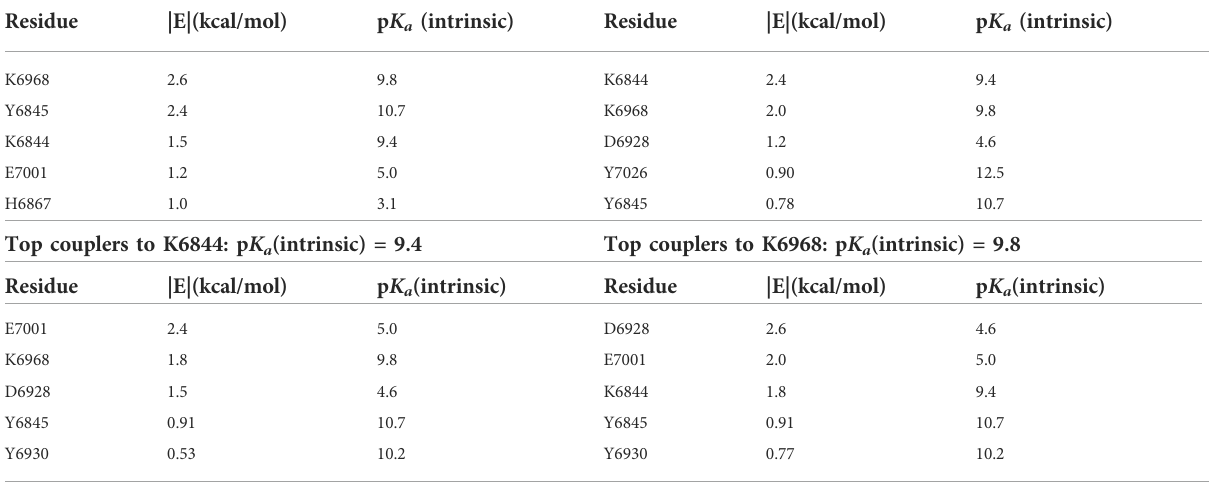
TABLE 4 Computed pairwise energies of electrostatic interaction (kcal/mol) between three of the members of the catalytic tetrad D-K-E, D6928, K6968, and K7001, plus the coupled K6844, and their fi ve strongest coupling partners for each, in the SARS-CoV-2 RNA methyltransferase. Intrinsic p K a s for each residue are also listed. Top couplers to D6928: p K a (intrinsic) =